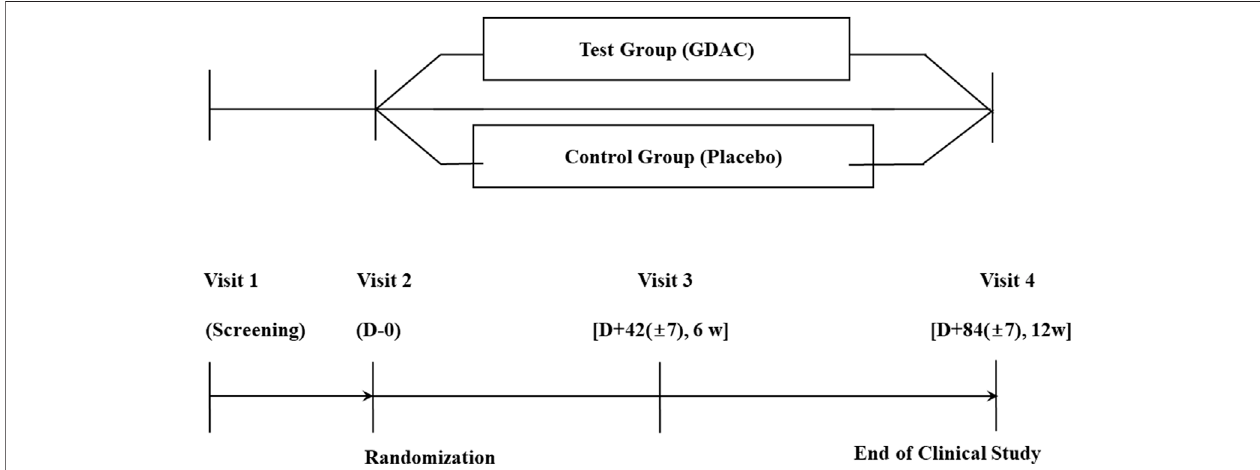
FIGURE2| A fl owdiagramoftheenrolmentprocessinthehumanstudy.Asubjectwhowishestobeenrolledinthisclinicalstudyshouldbegivenanexplanationof thestudyandevaluatedatthe1 st visit(Screeningvisit).Uponcompletionofour fi rstvisit,weplannedtoconductasecondvisitwithin14 daysandconductanevaluation. Threedaysafterthesecondvisit,athirdvisitwastohappen,andevaluationsweretotakeplace.Thefourthevaluationwasconducted84(±7) daysafterthesecondone.